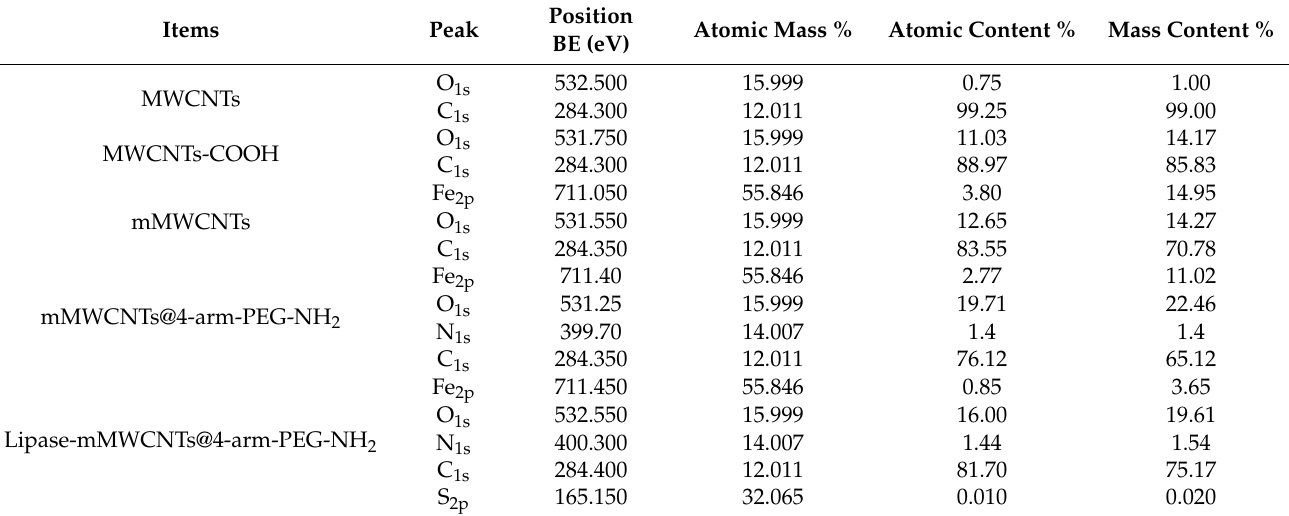
Table 1. Element information of MWCNTs after